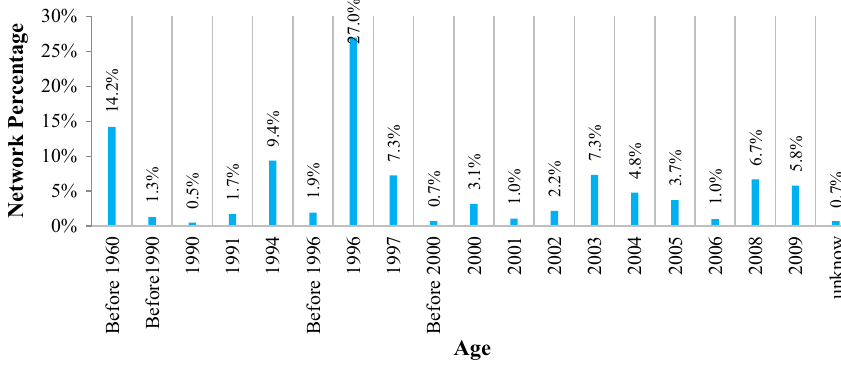
Fig. 4 Pipe ages of the Goma's water supply